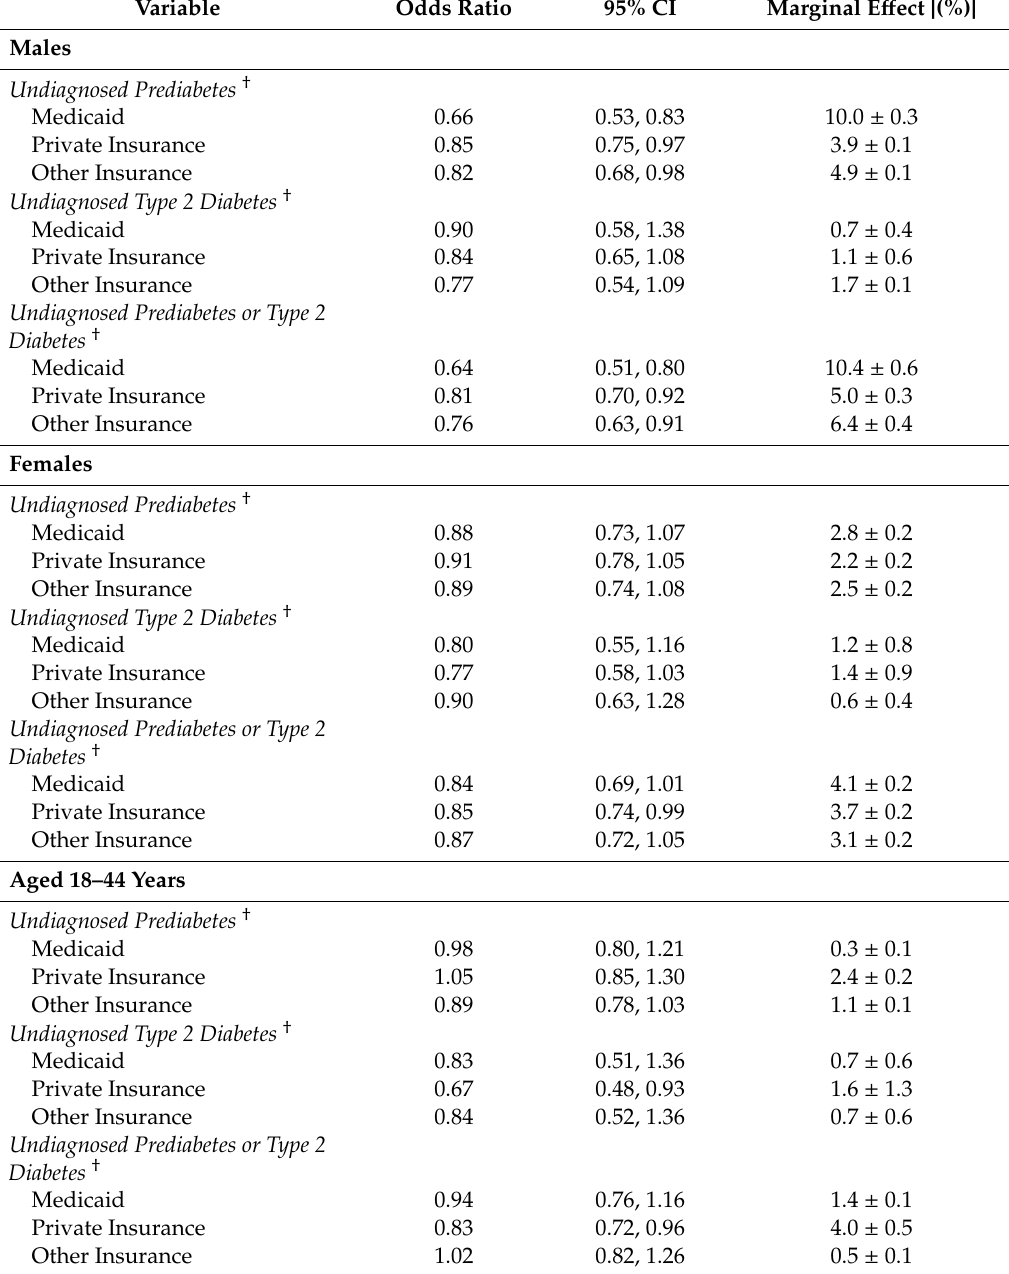
Table 3. Associations of health insurance type and undiagnosed prediabetes and type 2 diabetes stratified by sex and age